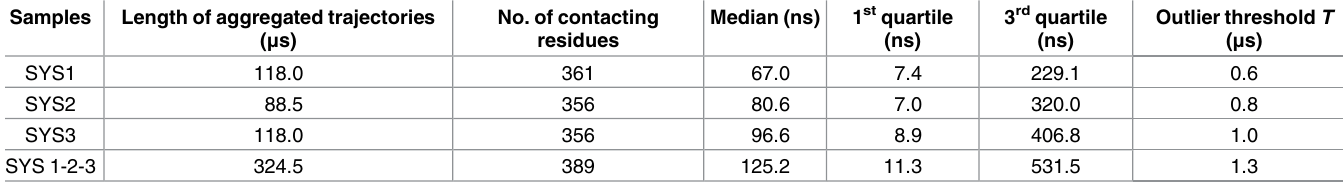
Table 2. Data spread of t max distributions obtained merging single data-setsand macro-samples as described by statistical test of hypothesis (Kruskall-Wallis). Samples Length of aggregated trajectories ( μ